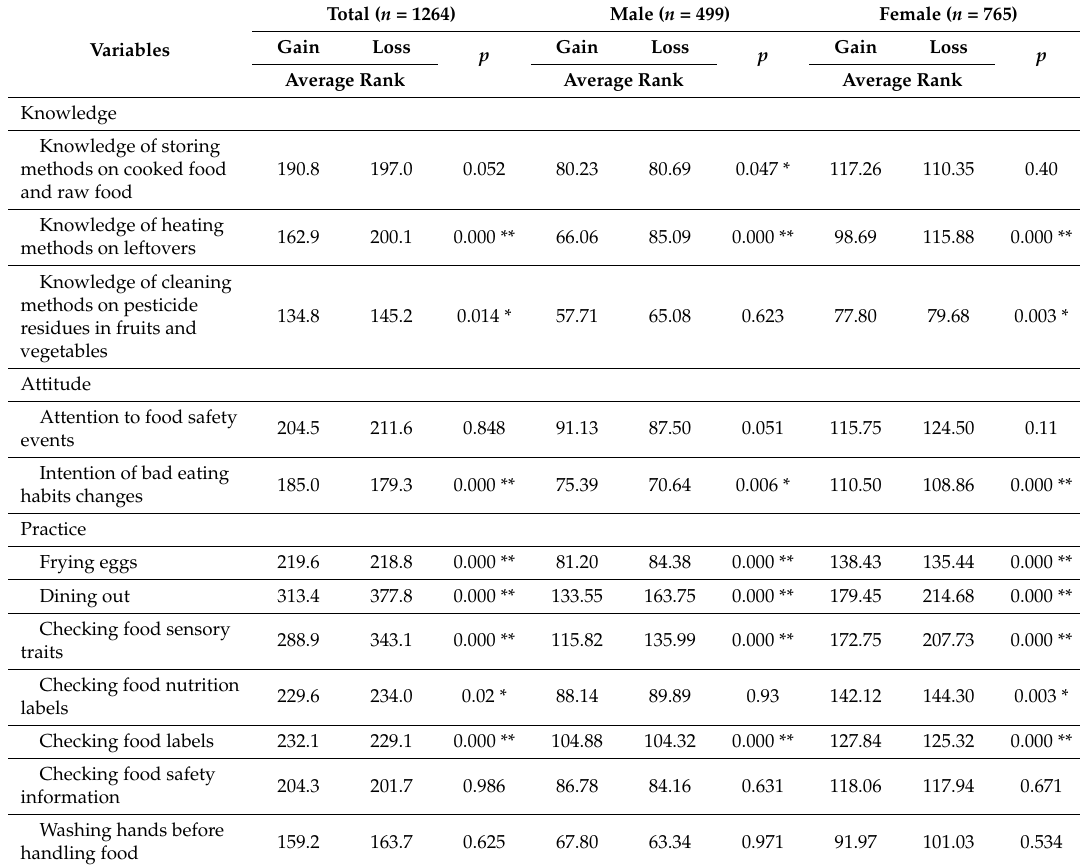
Table 3. Analyses of the gain- and loss-framed of food safety